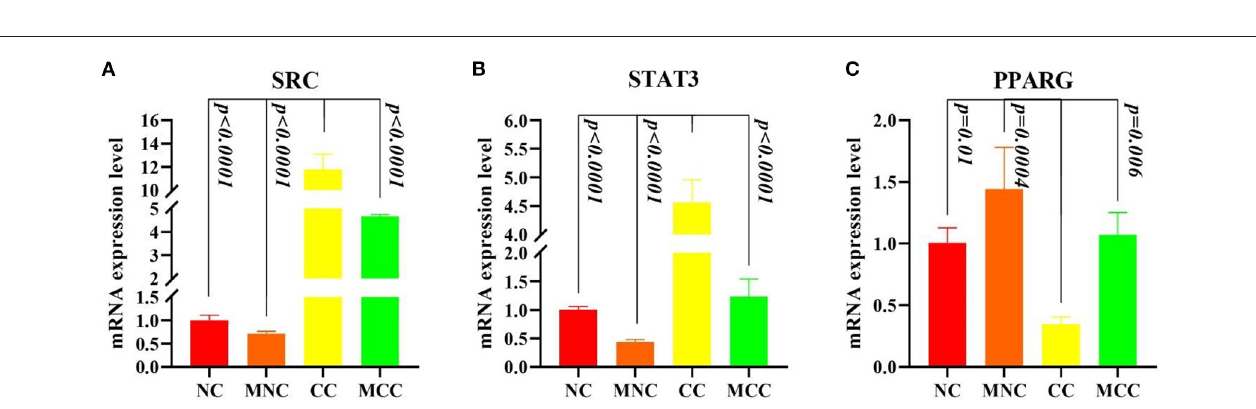
FIGURE 7 | (G) Demonstration of molecular docking of STAT3 and Puerarin. (H) Demonstration of molecular docking of STAT3 and Baicalein. (I) Demonstration of molecular docking of STAT3 and Berberine. (J) Demonstration of molecular docking of STAT3 and Glycyrrhizic acid. (K) Demonstration of molecular docking of PPARG and Magnolol. (L) Demonstration of molecular docking of PPARG and Puerarin. (M) Demonstration of molecular docking of PPARG and Baicalein. (N) Demonstration of molecular docking of PPARG and Berberine. (O) Demonstration of molecular docking of PPARG and Glycyrrhizic acid. The left side is the complete 3D stereo image of molecular docking, the middle is the 3D detail display image of molecular docking, and the right side is the 2D detail display image of molecular docking.